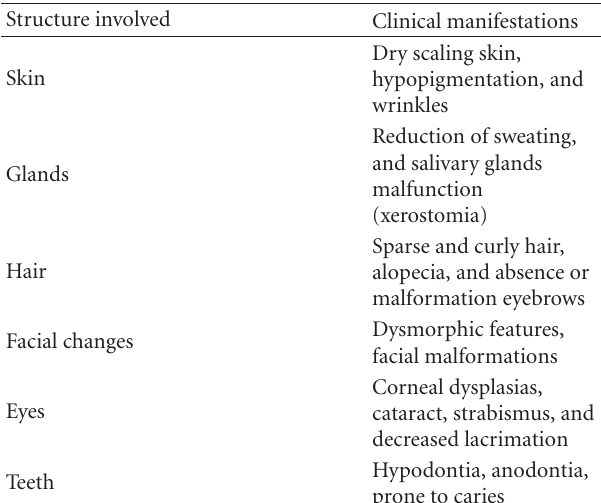
Table 1: Manifestations of ectodermal dysplasia more frequently observed.